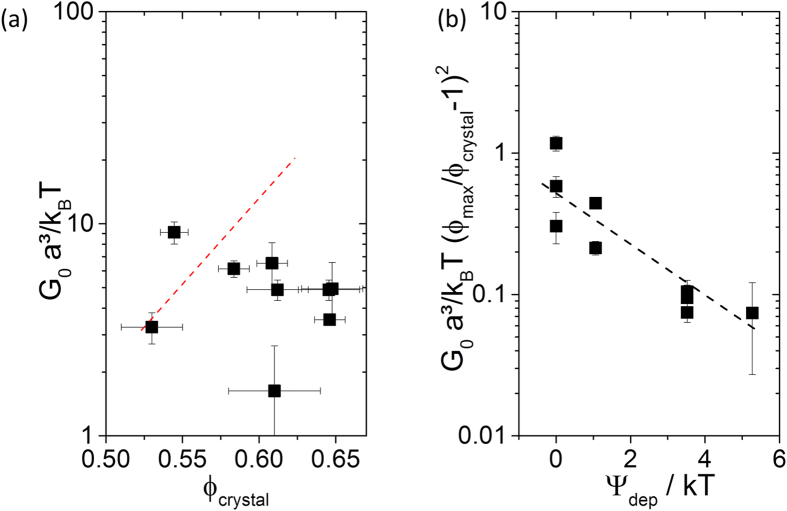
(a) Variation of the normalized plateau modulus G0 as a function of the estimated particle volume in the crystalline domain ϕcrystal as determined from the MPT measurements. The red dotted line represents previous experiments15 and simulations for hard sphere systems45. (b) Variation of the reduced plateau modulus G0a3 = kBT(ϕmax/ϕcrystal − 1)2 as a function of the depletion attraction potential Ψdep, including particle volume fraction scaling as suggested by45. In this case, ϕmax is set as the maximum volume fraction of a hcp-crystal (0.74). The dotted line serves as a guide to the eyes.